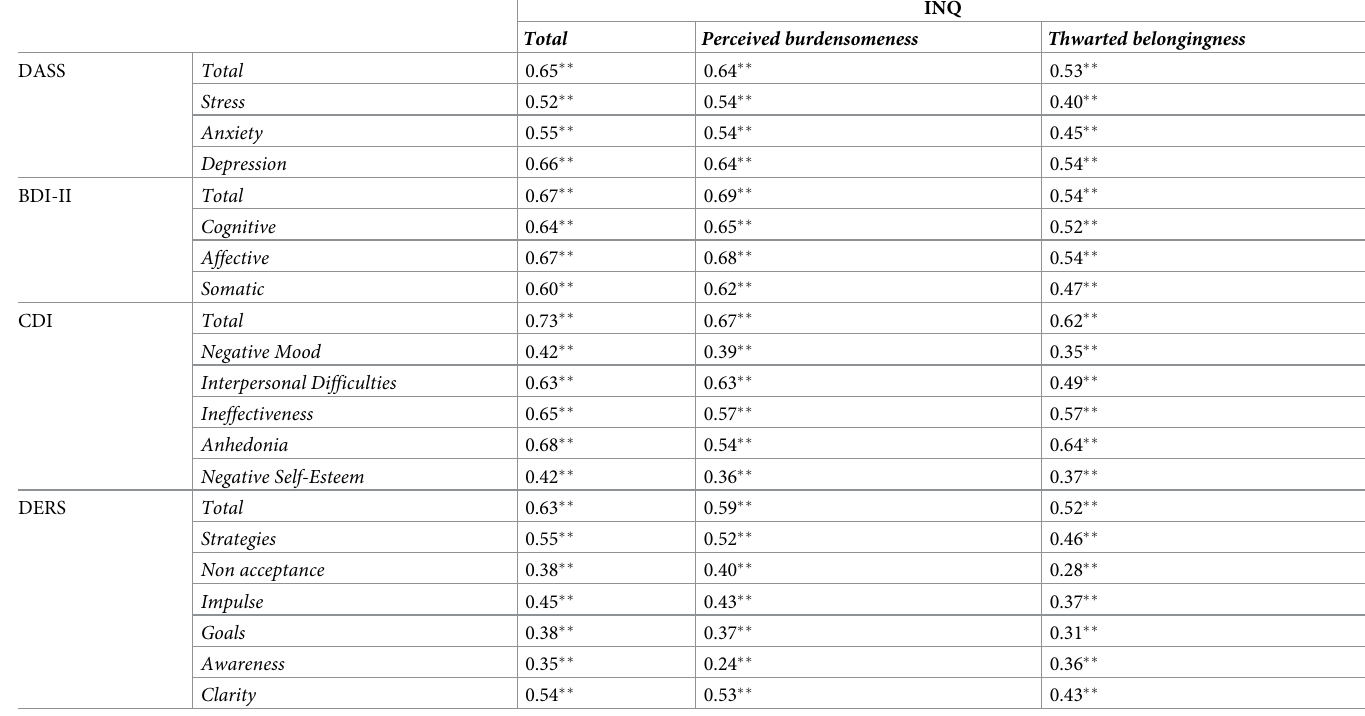
Table 2. The correlation coefficient between INQ-15 and the criterion